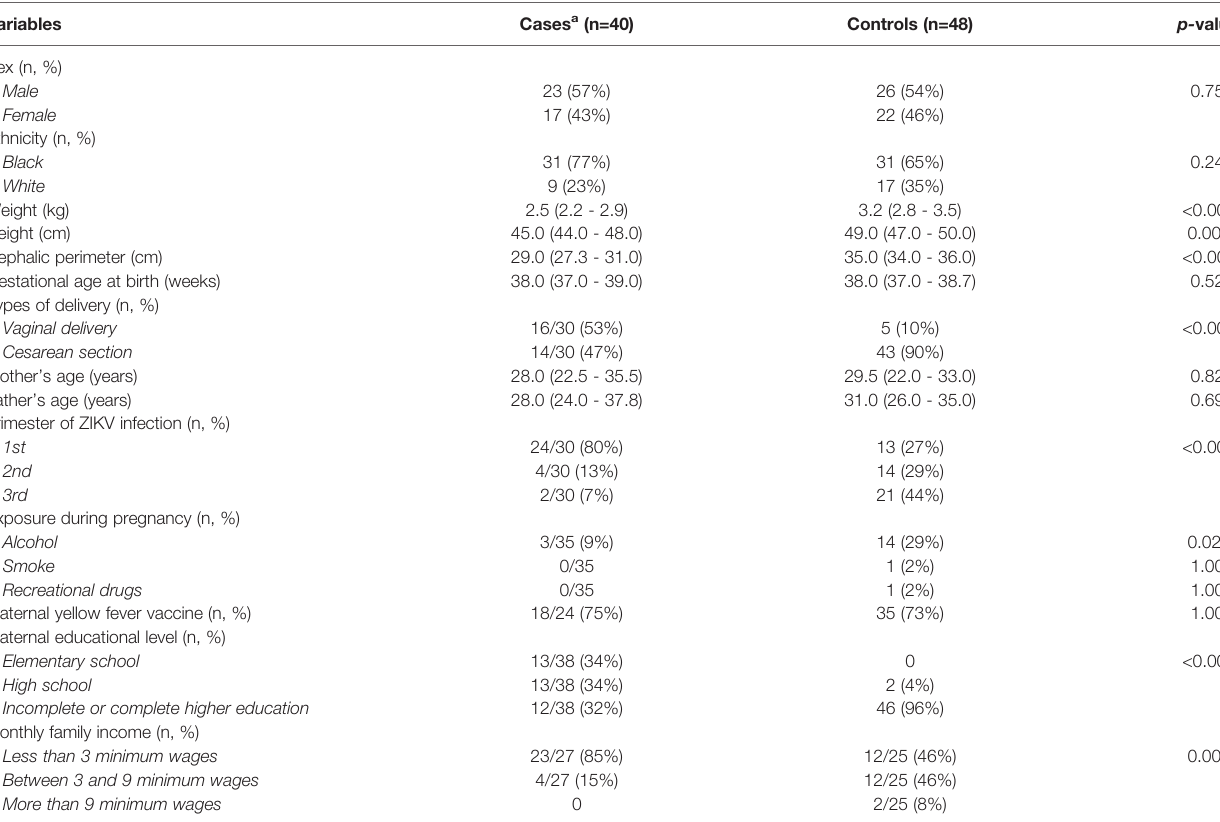
TABLE 1 | Evaluation of clinical, gestational, and sociodemographic characteristics in the case (CZS) and control (without CZS) groups. Variables Cases a (n=40)